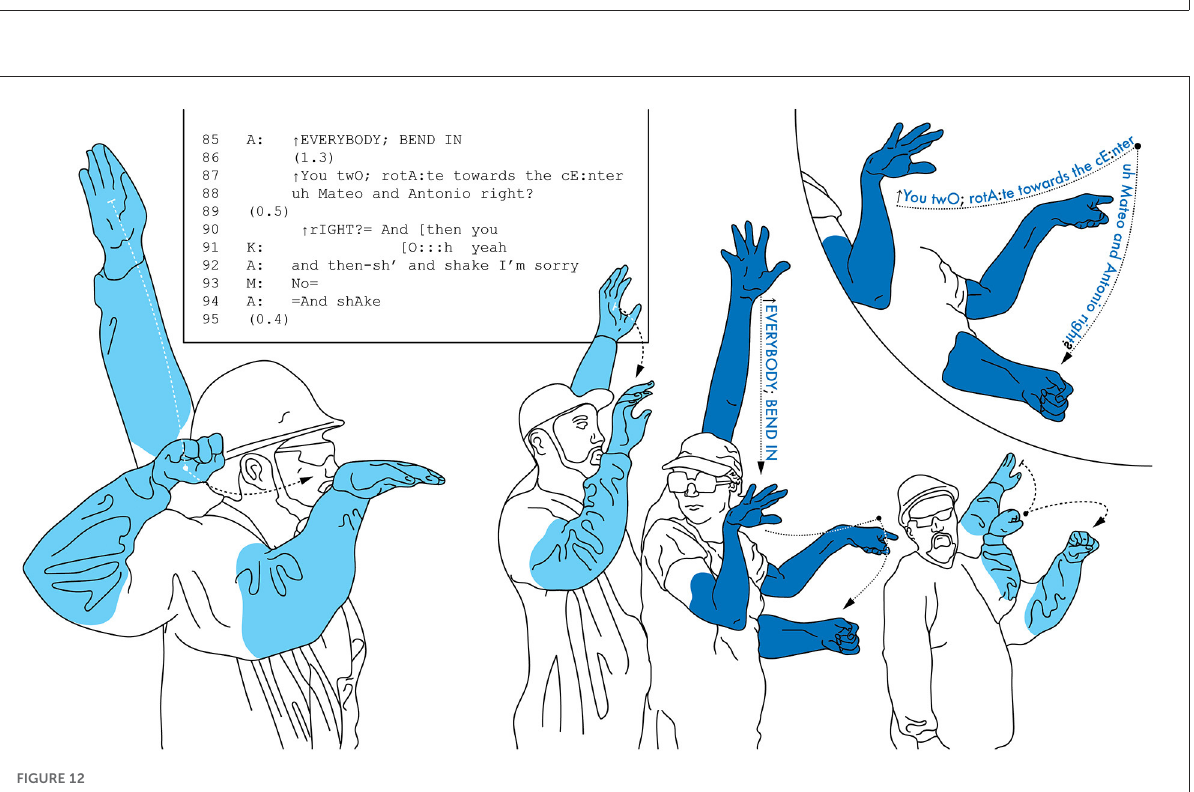
FIGURE12 Transcript